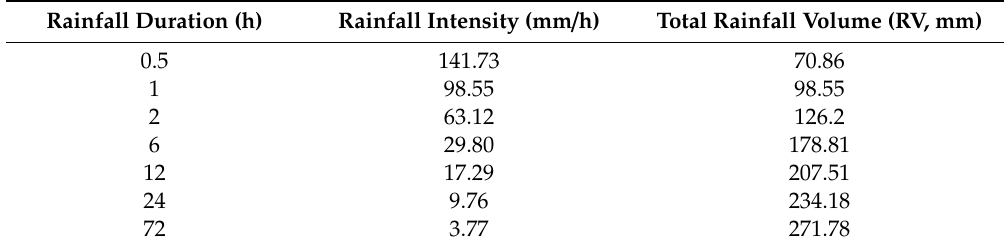
Table 4. Selected Precipitation pattern for FEM